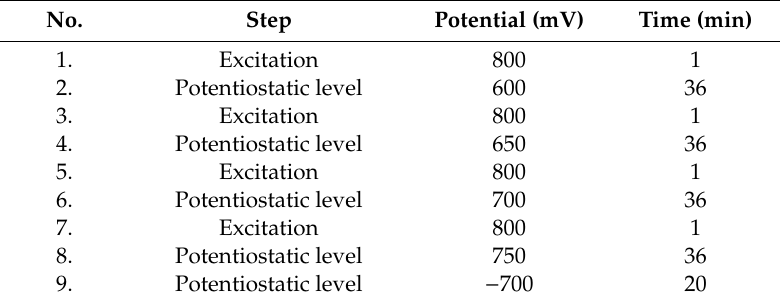
Table 3. Composition of an electrochemical measurement cycle